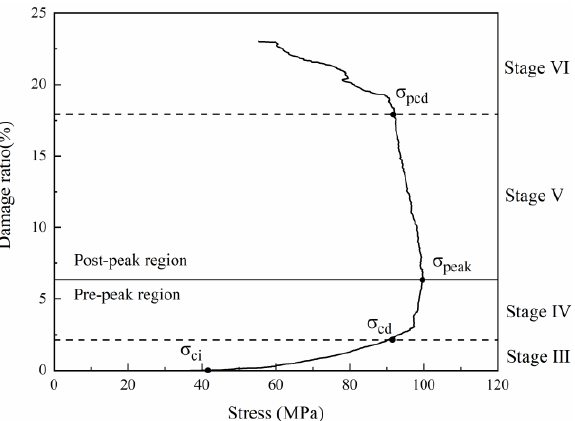
Figure 11. Cumulative damage and axial stress change curve. Note: Damage rate (%) = number of cracks/total number of joints × 100%.